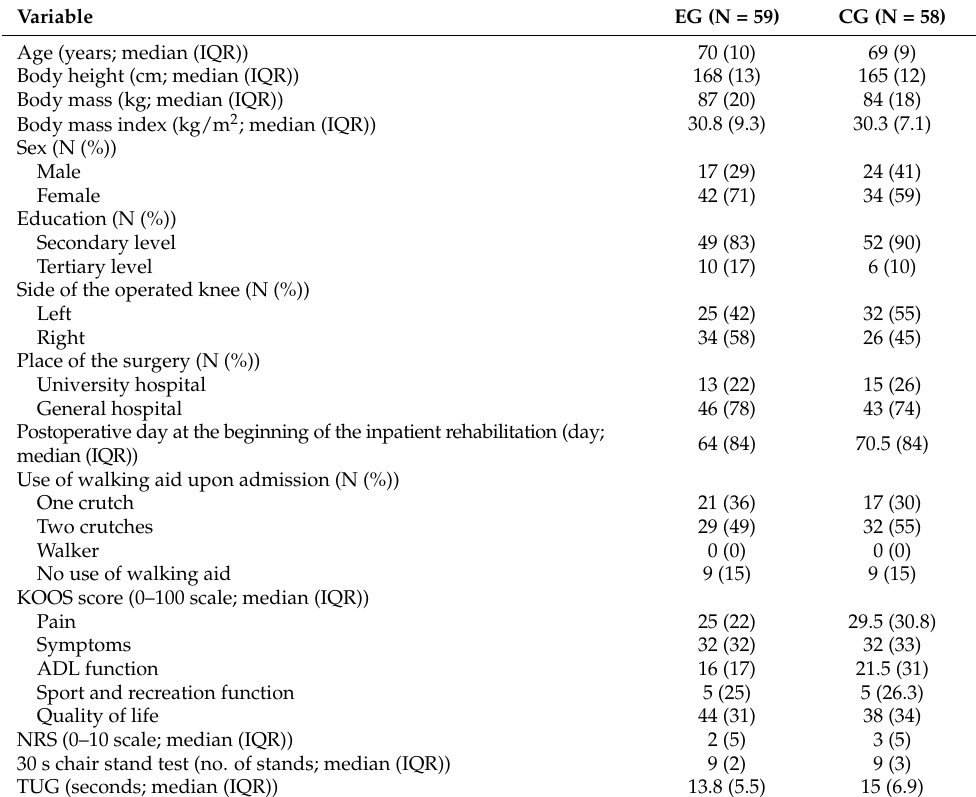
Figure 1. Consolidated Standards of Reporting Trials (CONSORT) flowchart of the study showing recruitment of participants. Table 1. Baseline characteristics for the experimental and control group.